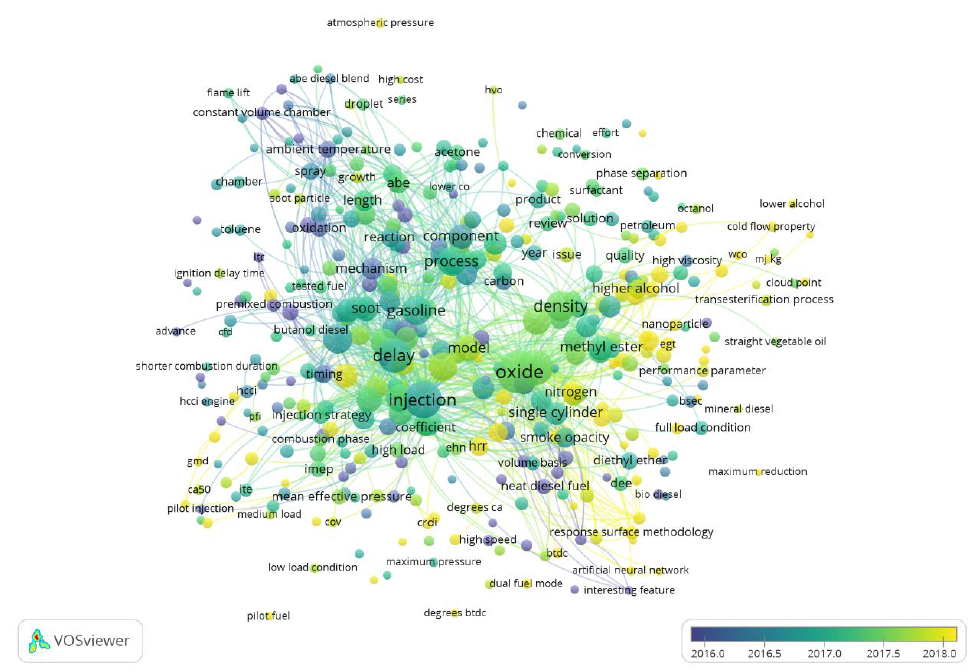
Figure 5. Research topics provided by Web of Science, Clarivate, including butanol/diesel fuel